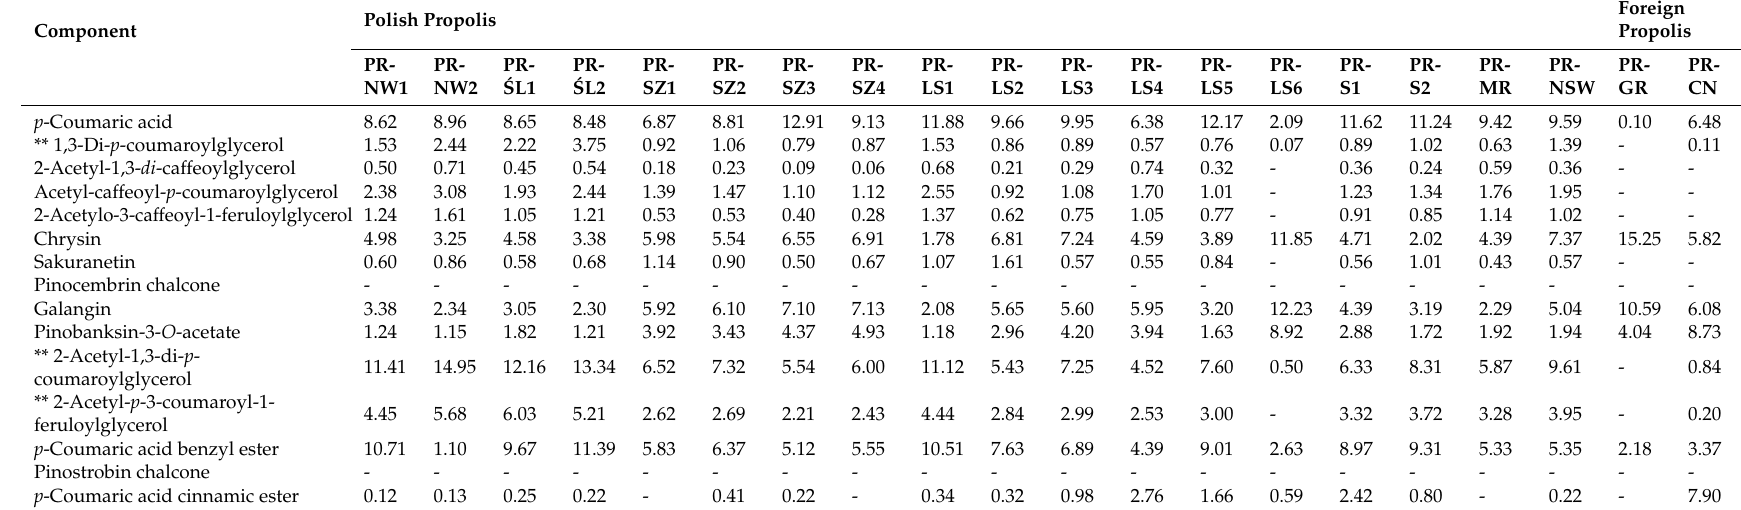
Table 6. Main components of propolis 70% ethanol in water extracts